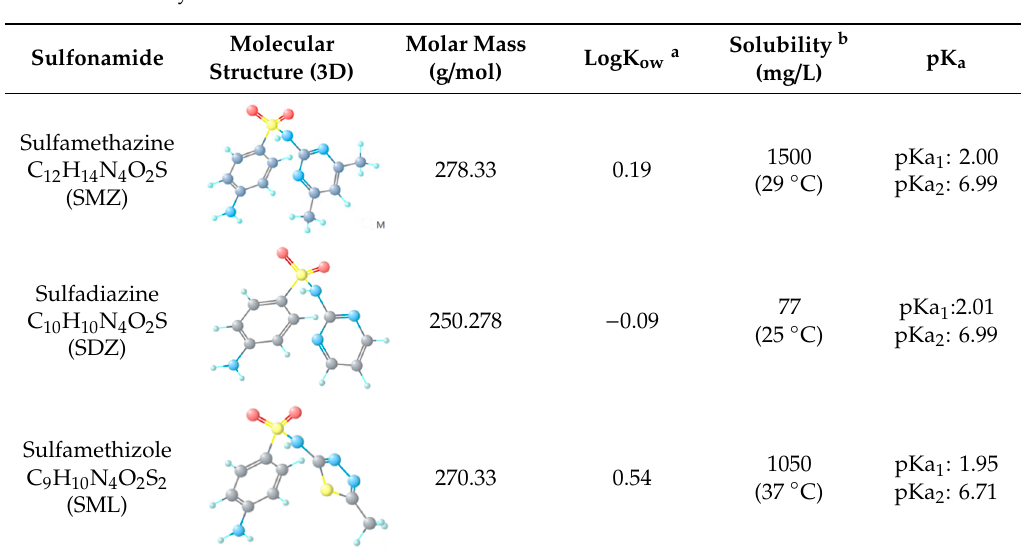
Table 1. Molecular structure and physicochemical properties of the 4-aminobenzene sulfonamides used in this study.